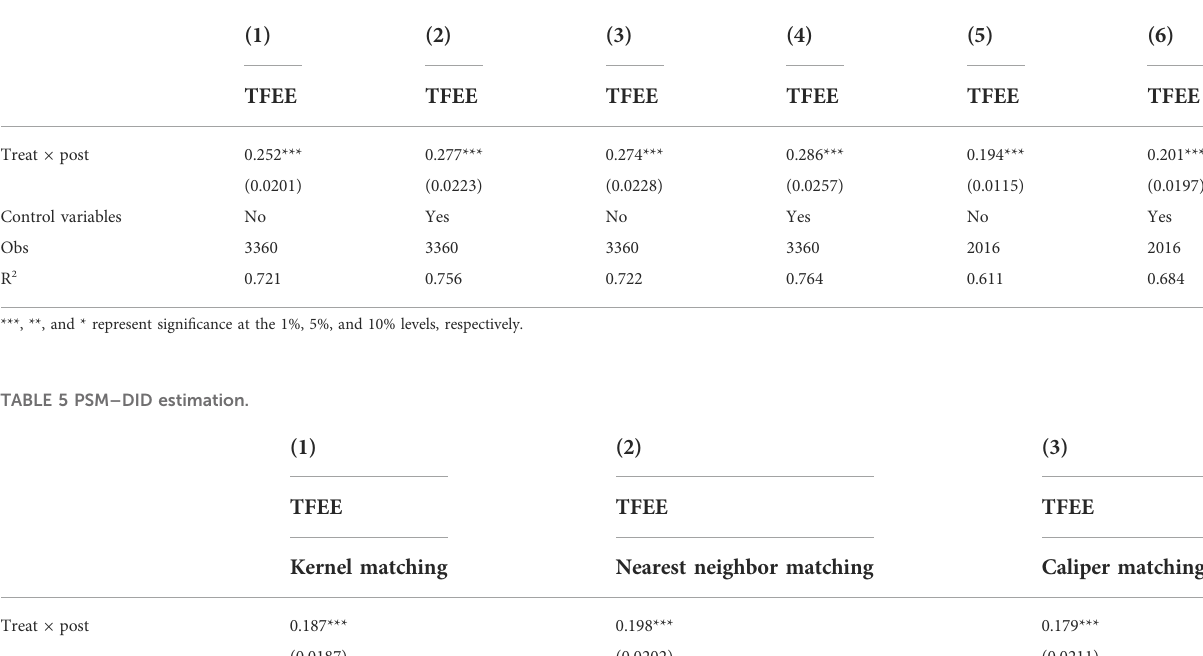
TABLE 4 Climate and energy policy effect exclusion.